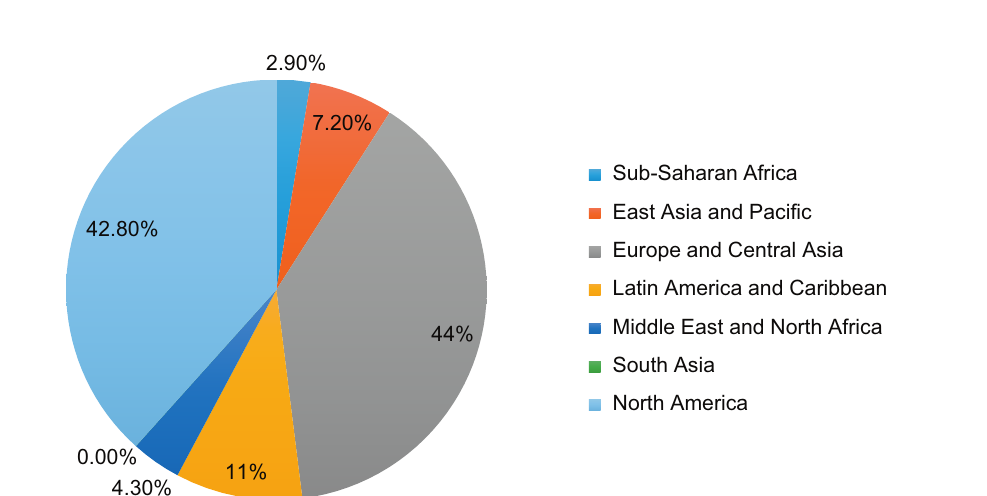
Figure 5. Percentage of non-LMIC collaborative authors by World Bank Region from 2004 to